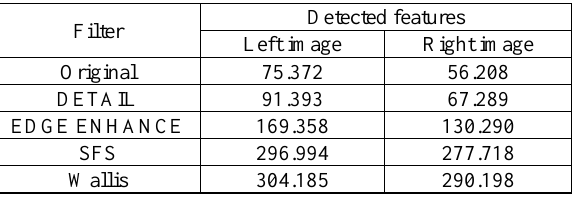
Table 4. Numbers of detected features for the left and right images of the selected stereo couple for each of the employed image-enhancement filters. Table 5. Numbers of matched features using both FLANN and